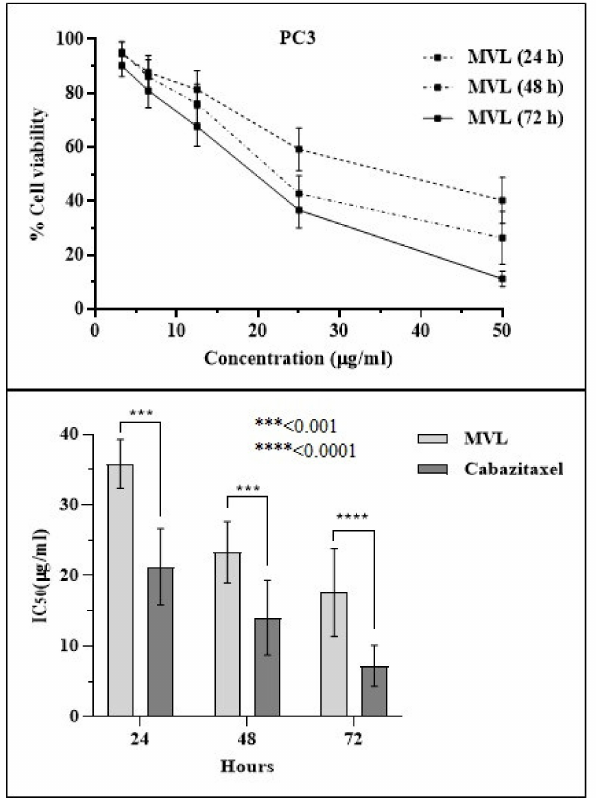
Figure 4. Effect of MVL on the viability of prostate cancer cells. MTT assay was used to determine the viability of cancer cells after 24, 48, and 72 h treatment of PC3 cells. Data is mean ± SEM of % cell viability ( n = 3) at ***: p < 0.001 and ****: p <